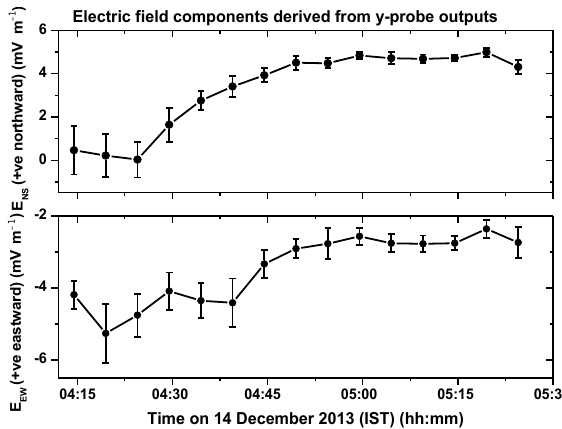
Figure 15. The 5min averages of electric field components de- rived from the horizontal probe outputs, the northward component or E NS plotted in the top panel and the eastward component or E EW plotted in the bottom panel. The error bars represent the stan- dard deviation for the electric field estimates made for the individual 5min blocks. It should be noted that the east–west and north–south directions are referenced in the geomagnetic